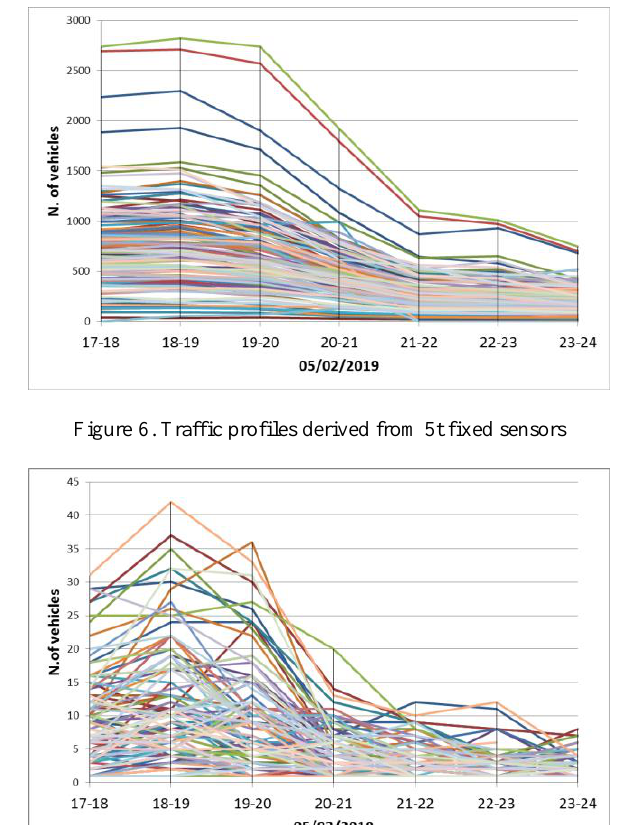
Figure 7. Traffic profiles derived from FCD